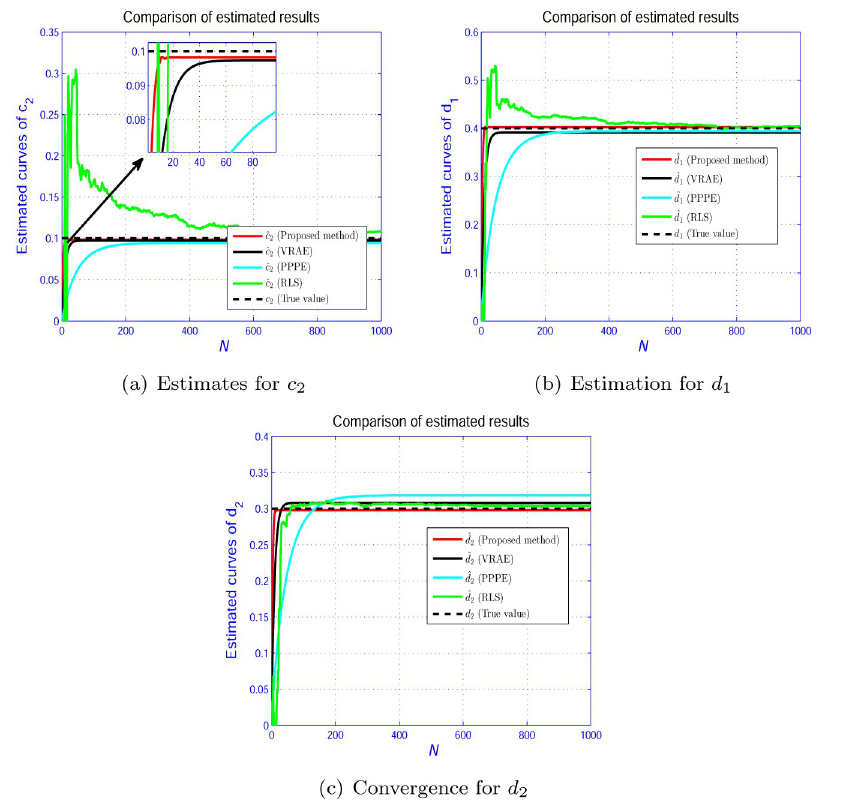
Fig 7. Parameter estimation for L 2 . (a) Estimates for c 2 . (b) Estimation for d 1 . (c) Convergence for d 2 .